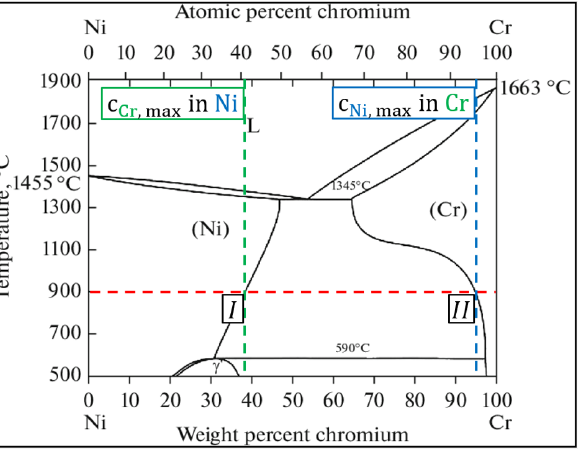
Figure 6. Ni-Cr alloy phase diagram, identification of the temperature-dependent solubility of ele- ments in their solid solutions